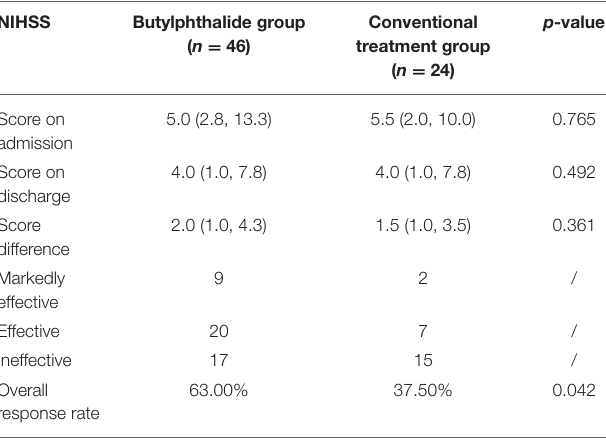
TABLE 4 | Changes in the National Institutes of Health Stroke Scale (NIHSS) after admission according to the treatment groups. p NIHSS Butylphthalide group Conventional ( n = 46) treatment group ( n = 24)